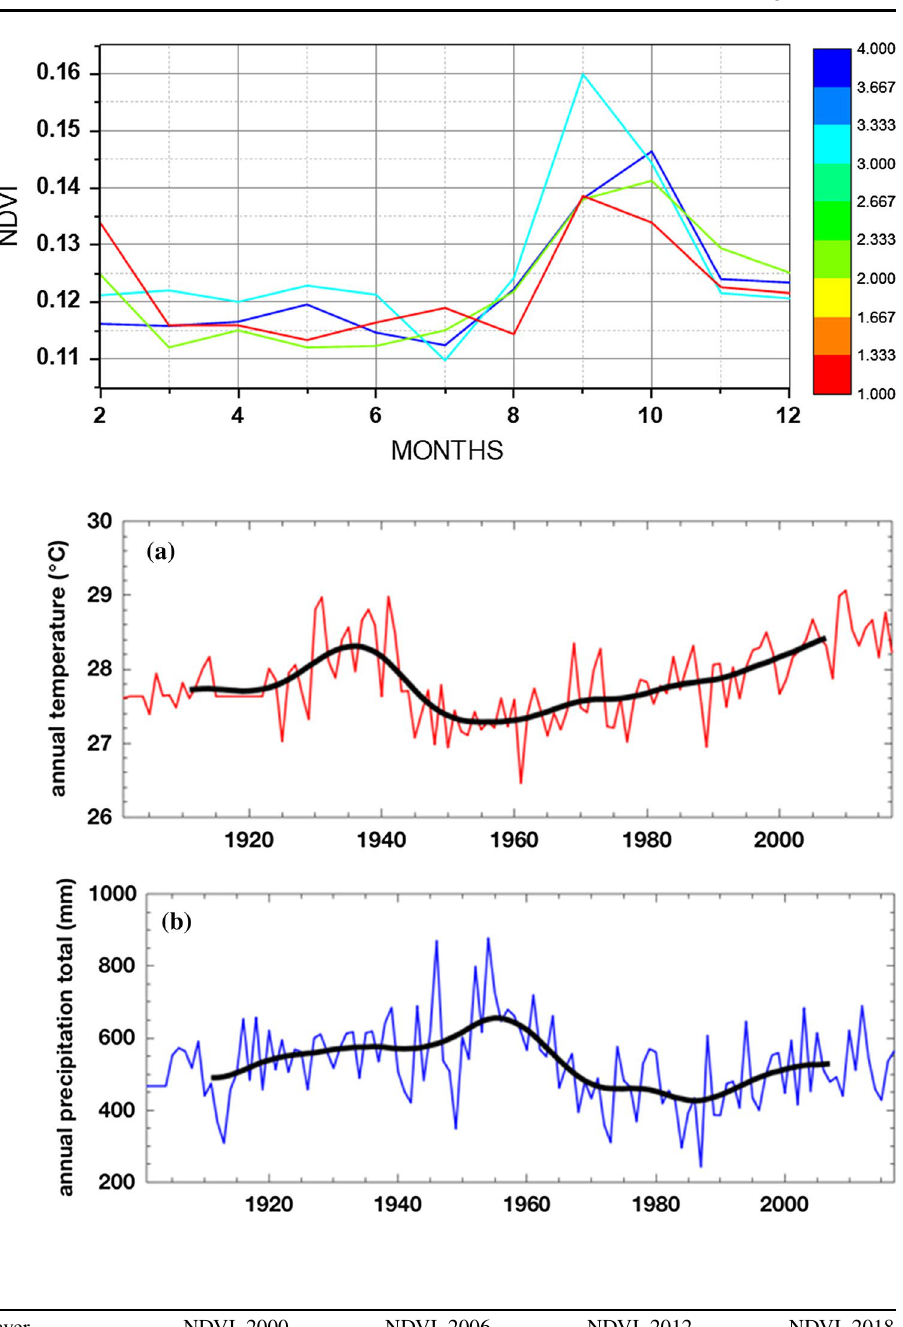
Fig. 7 Comparative study of NDVI values of the time series from 2000, 2006, 2012 and 2018